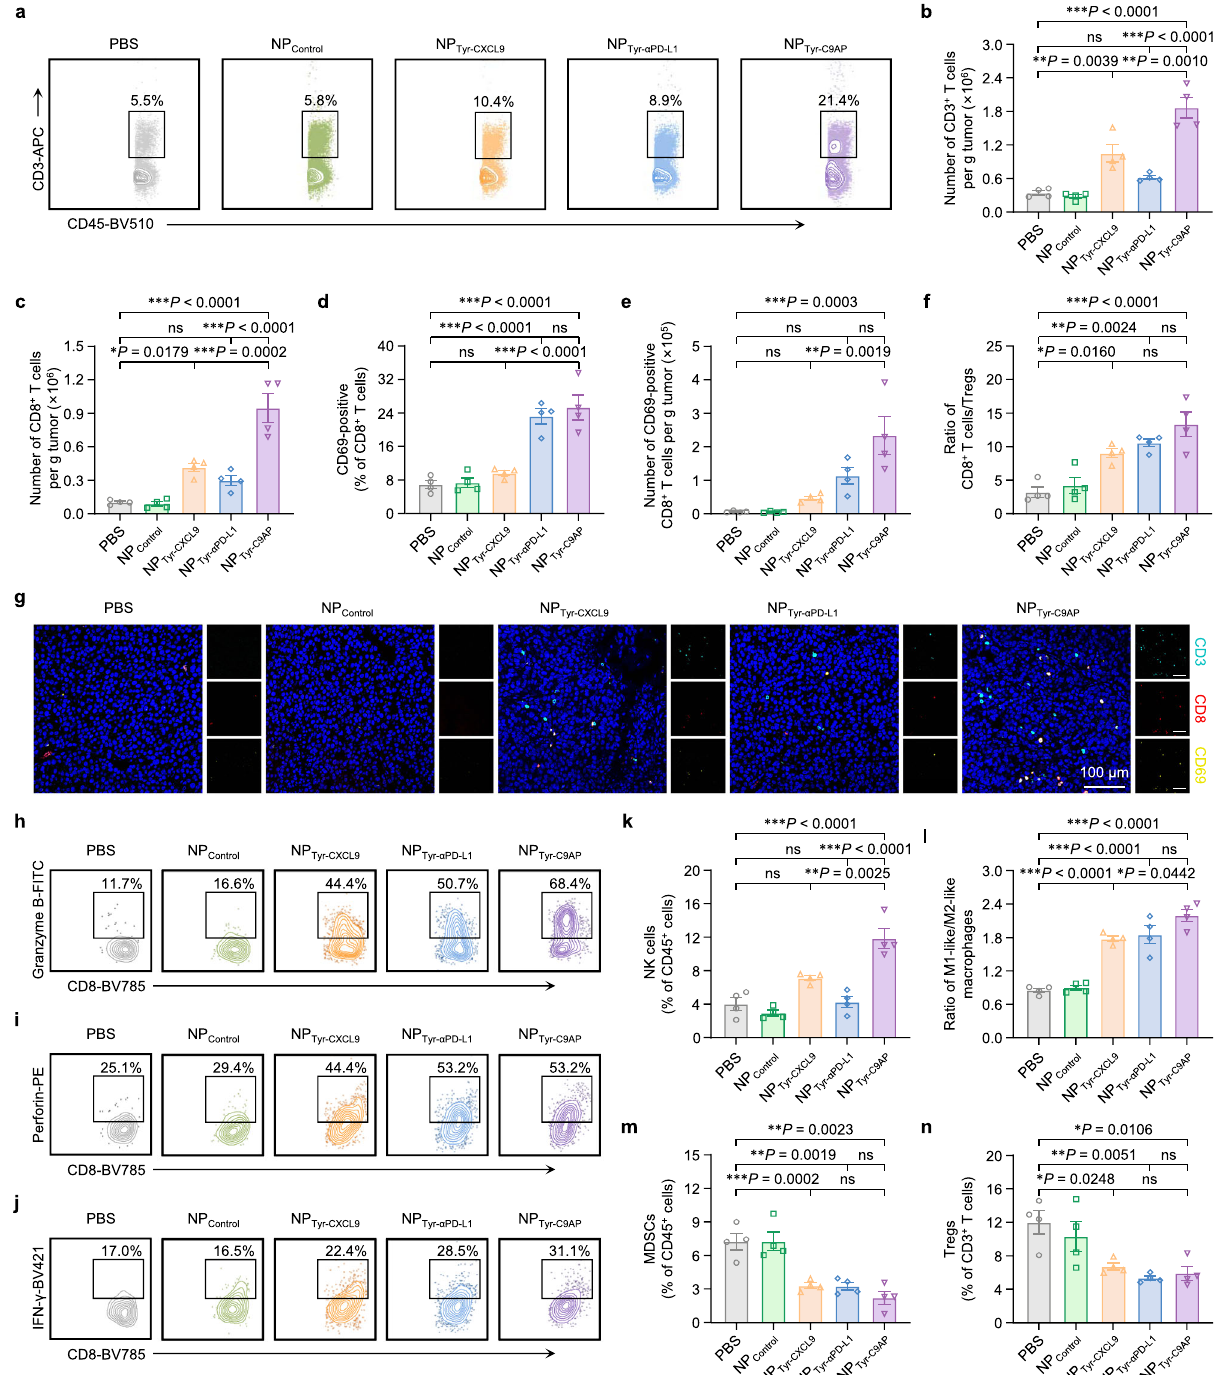
Fig. 5 | Pro fi ling of the improved intratumoral in fi ltration and activation of T cells after NP Tyr-C9AP treatment. a , b Flow cytometry plots of CD3 + T cell per- centagesinCD45 + cells( a )ornumbersofCD3 + Tcells( b )ofthemelanomasamples from the mice treated with NP Tyr-C9AP or other controls ( n =4 mice per group). c Numbers of CD8 + T cells in melanoma. d , e Percentages ( d ) and numbers ( e ) of CD69-positive CD8 + T cells in melanoma. f Ratios of CD8 + T cells/Tregs in mela- noma. g Representative immuno fl uorescence images of the melanoma. CD3 (aqua green), CD8 (red) and CD69 (yellow) of T cells were labeled by fl uorescent anti- bodies. Scale bar, 100 μ m. h to j Representative fl ow cytometry plots of granzyme